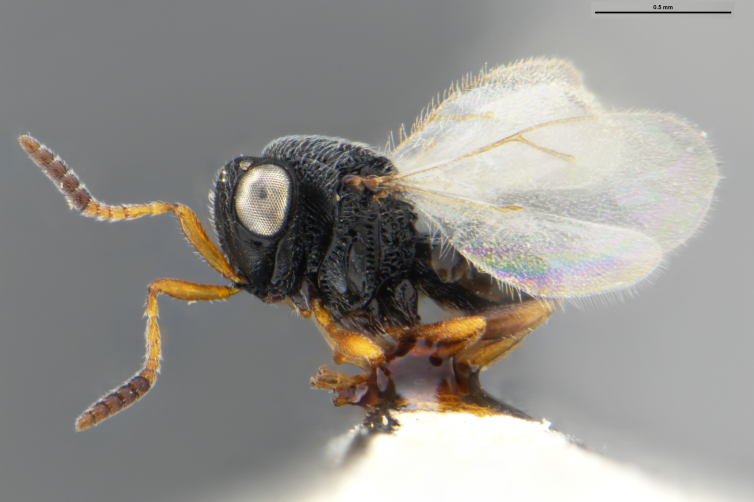
lateral habitus